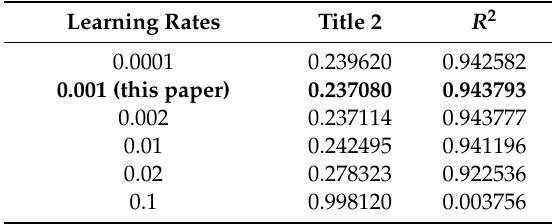
Table 2. Prediction performance of DNN models with di ff erent learning